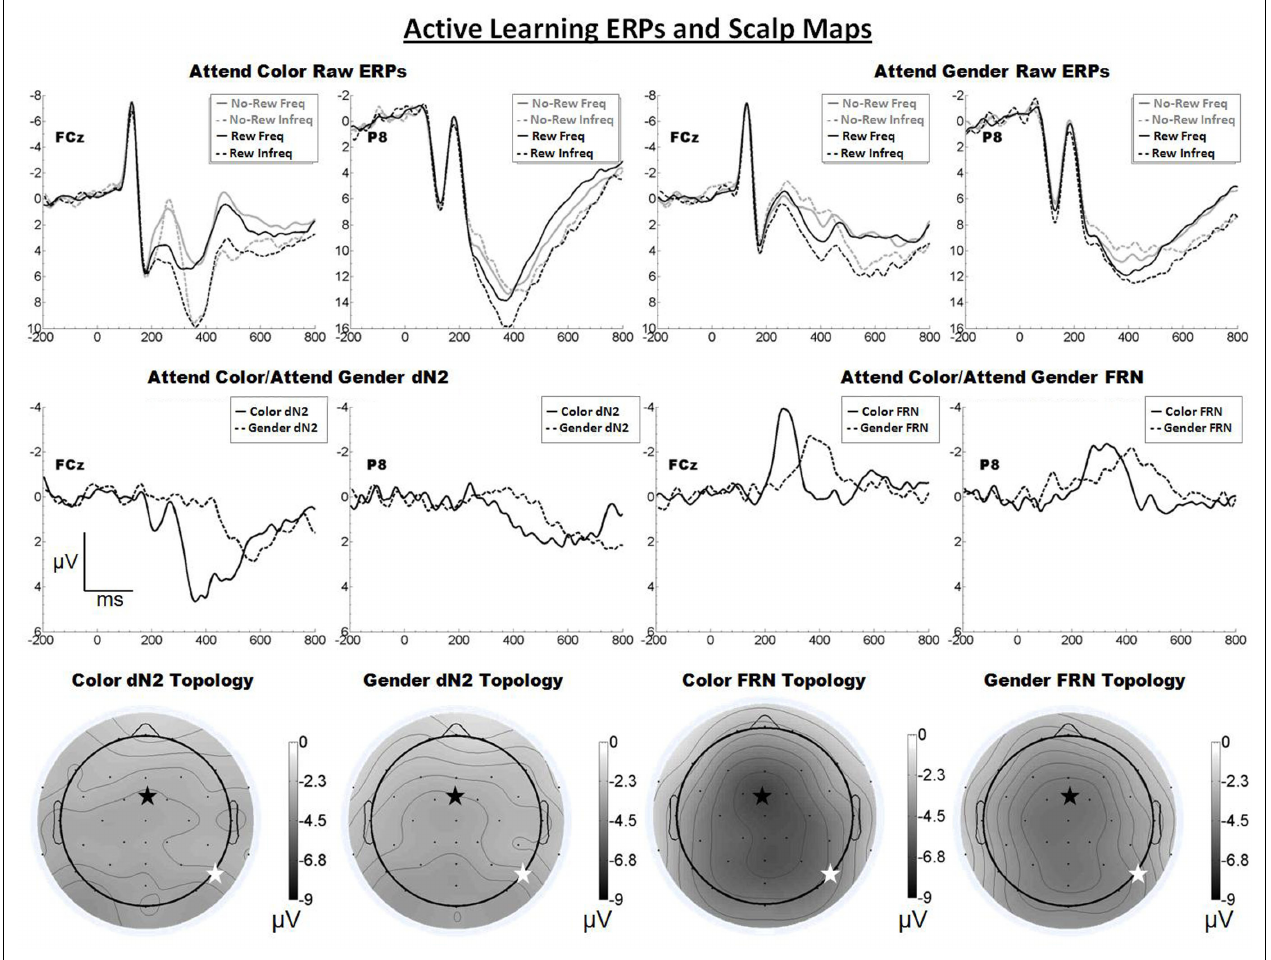
electrodes.The bottom row shows the scalp distributions of the dN2 and FRN across tasks.The scalp distributions reflect the base-to-peak measure of each of the dN2 and FRN.The black star on the scalp map denotes channel FCz, and the white star denotes P8. Note that negative is plotted